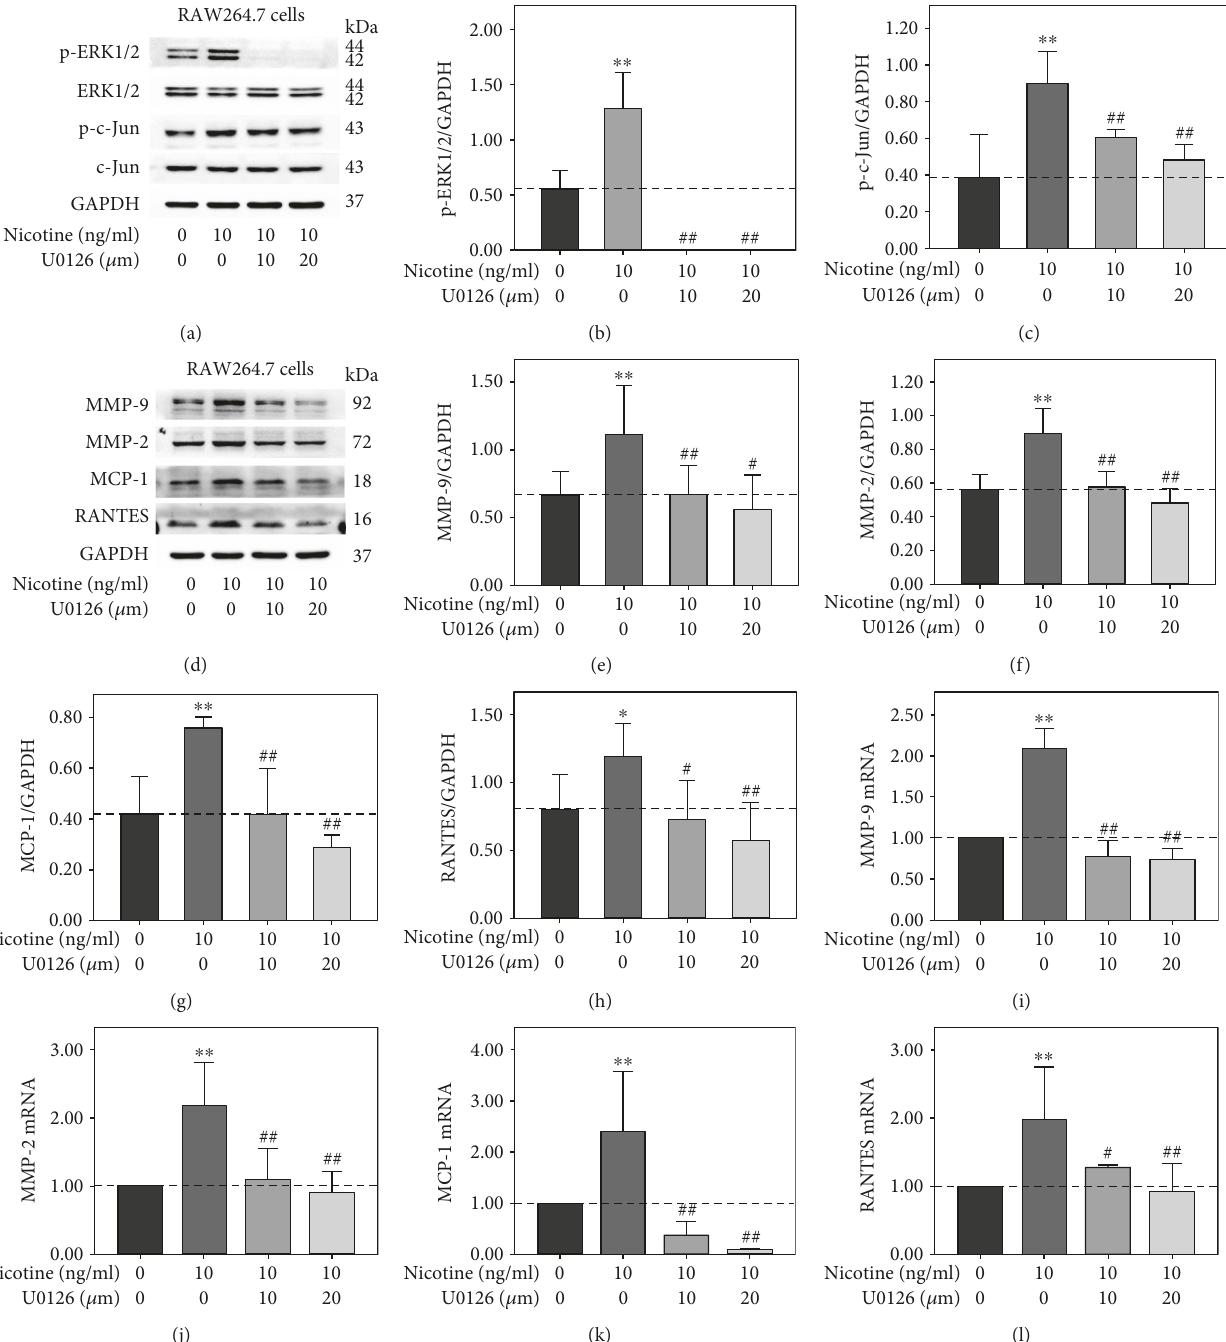
Figure 2: U0126 attenuated nicotine-induced activations of extracellular signal-regulated kinase1/2 (ERK1/2) and c-Jun and upregulation of matrix metalloproteinase- (MMP-) 9, MMP-2, monocyte chemotactic protein- (MCP-) 1, and regulated upon activation normal T cell expressed and secreted (RANTES) in RAW264.7 cells. (a) RAW264.7 cells were pretreated with 10 μ m and 20 μ m U0126 for 30 min prior to 10ng/ml nicotine exposure for 30 min. (d) RAW264.7 cells were pretreated with 10 μ m and 20 μ m U0126 for 30 min prior to 10ng/ml nicotine exposure for 3h. (b, c, e – h) The intensity of protein bands (means ± SD) in the Western blot were quanti fi ed by using ImageJ software and normalized to GAPDH. Representative results from three independent experiments are shown. (i) MMP-9, (j) MMP-2, (k) MCP-1, and (l) RANTES mRNA levels were determined by real-time reverse transcription polymerase chain reaction. All experiments were analyzed as triplicate independent experiments. ∗ p < 0 05 and ∗∗ p < 0 01 versus controls; # p < 0 05 and ## p < 0 01 versus the group treated with